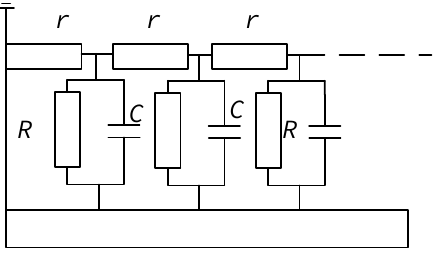
Figure 10. The equivalent circuit of a bushing.